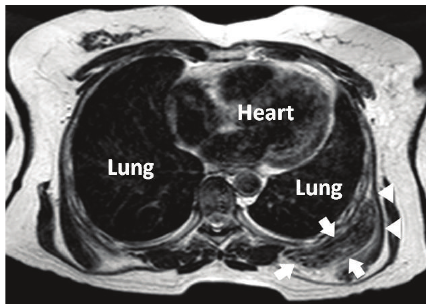
Figure 1: The T1 and T2 weighted MRI examination of the mass showed a localized heterogeneous mass of 64 × 16mm adjacent to the left scapula. Please note the hyperintense adipose tissue in the form of lines and hypointense fibrous tissue.